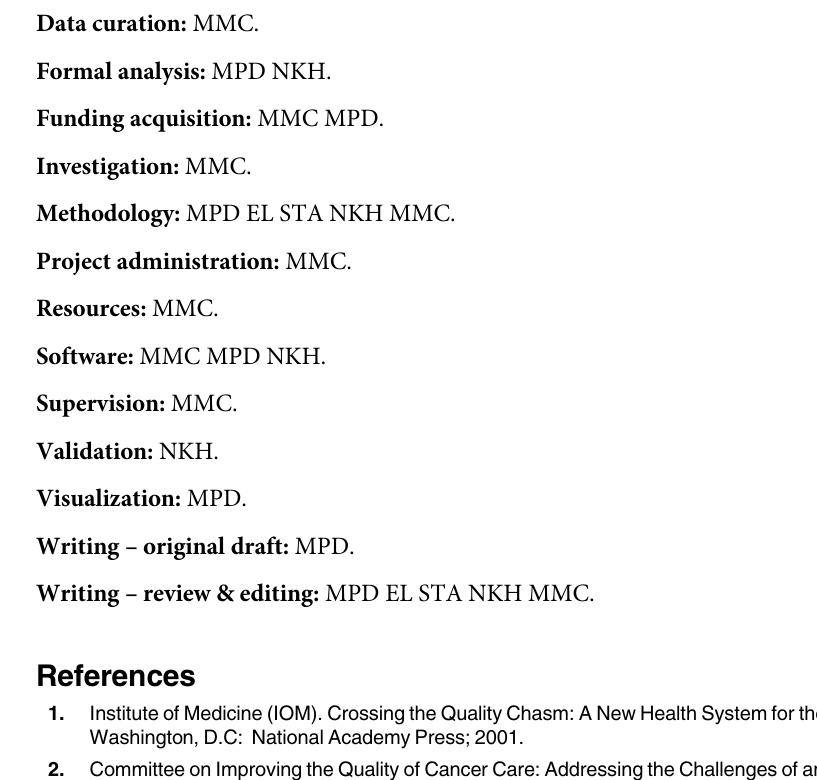
S2 Fig. Tumor recurrence sample derivation. S3 Fig. Five-year tumor recurrence. (a) Electrodesiccation and curettage, (b) Excision, and (c) Mohs